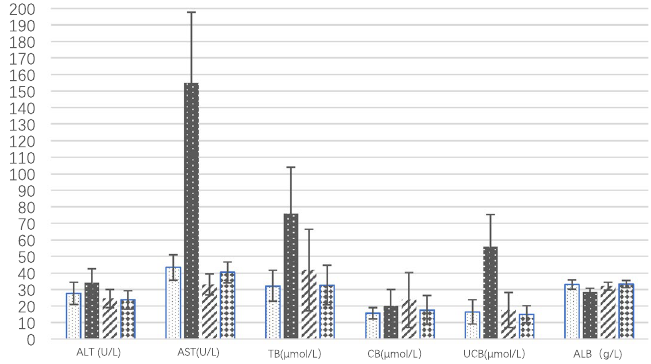
Figure 5. Liver function changes pre-HIFU and post-HIFU.